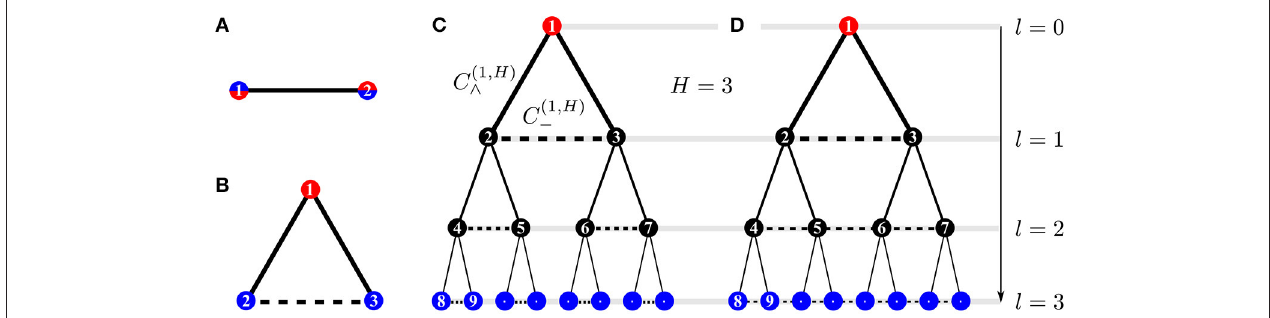
FIGURE 1 | Network structures: (A) motif with 1 fluctuating source and 1 sink (2-node model), (B) motif with 1 constant source and 2 fluctuating sinks (3-node model), and “augmented trees” (C,D) , i.e., tree-like structures with cross-edges (dashed horizontal edges) that connect only nodes in each minimal subtree, thus forming a “triangular tree ” (C) , or connect all nodes within one tree level l by a path as in (D) . Thus, cross edges introduce cycles to the network. The constant source at the root and the fluctuating sinks in the leaves of the tree are shown in blue and red, respectively, and l denotes the branching level in the tree-like